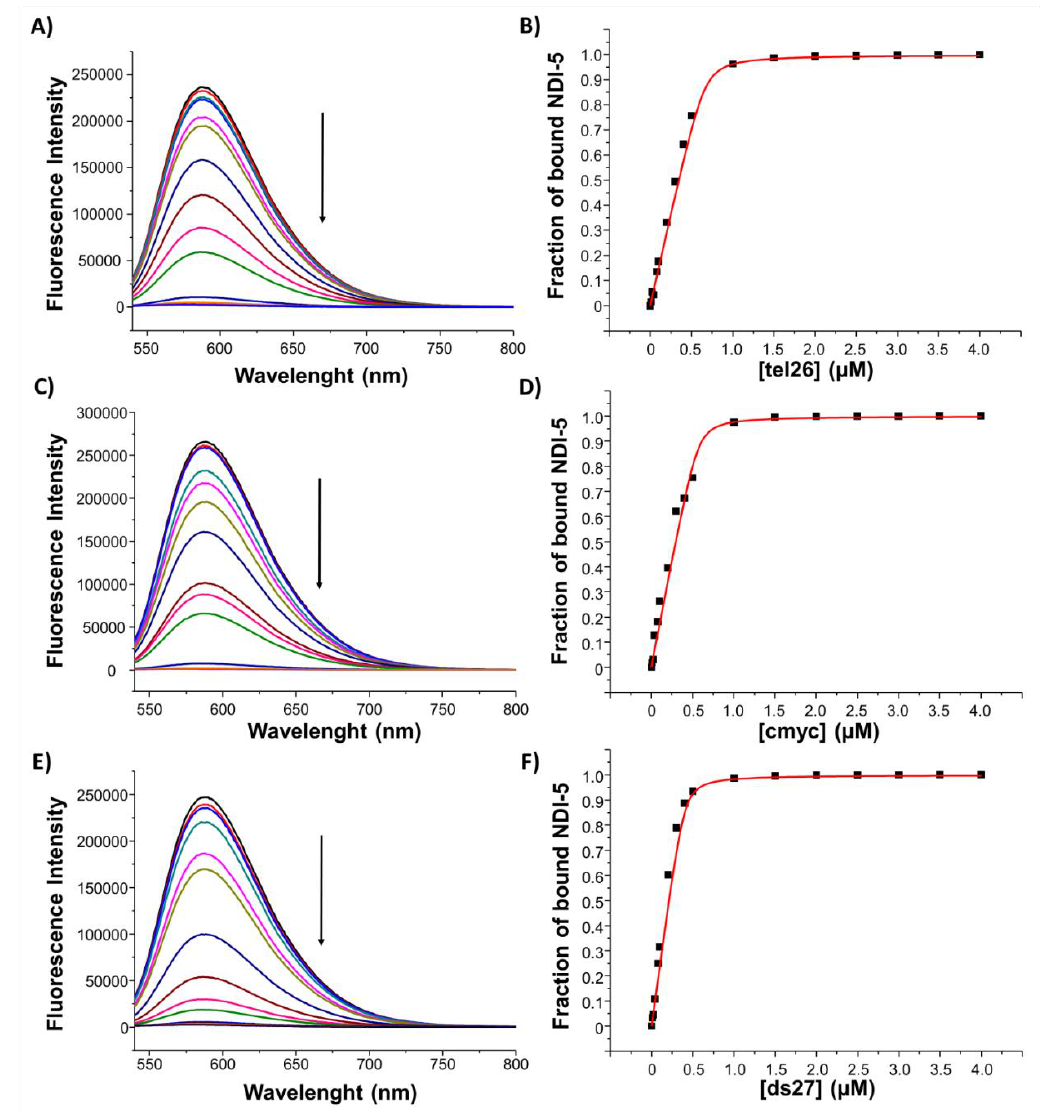
Figure 9. Fluorescence titration experiments for NDI-5 . Left: fluorescence spectra obtained by adding increasing amounts of ( A ) tel26, ( C ) cmyc and ( E ) ds27 to 2 µM solutions of NDI-5 . Right: representative binding curves obtained by plotting the fraction of bound ligand NDI-5 as a function of ( B ) tel26 G4, ( D ) cmyc G4 and ( F ) ds27 hairpin duplex concentration. The black squares represent the experimental data; the red line is the best fit obtained with an independent and equivalent-sites model. The experiments were performed in 20 mM KCl, 5 mM KH 2 PO 4 and 10% DMSO buffer (pH 7). The excitation wavelength was 526 nm. The arrows indicate increasing DNA concentration.